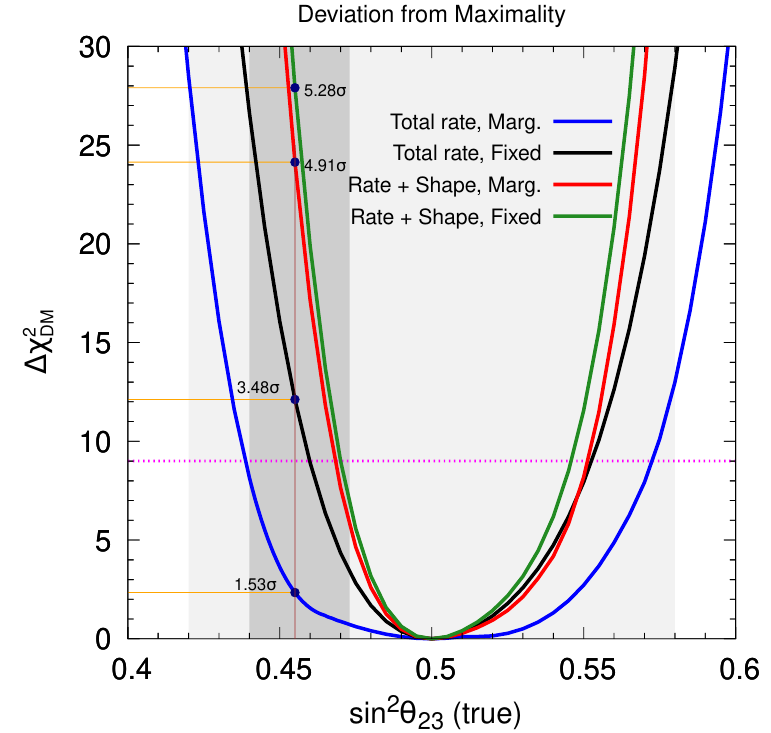
Figure 8 . Potential of DUNE to establish deviation from maximality as a function of true sin 2 θ 23 assuming true NMO and δ (true) = 223 ◦ with the combined 3.5 years ν + 3.5 years ¯ ν run. CP Blue (Black) curve shows the performance based on total event rates when ∆ m 2 and δ are CP 31 marginalized (fixed) in the fit. Red (green) curve depicts the sensitivity based on rate + shape analysis when ∆ m 2 and δ are marginalized (fixed) in the fit. See text for details. The dark CP 31 (light)-shaded grey area shows the currently allowed 1 σ (2 σ ) region in sin 2 θ as obtained in the 23 global fit study [11] with the best-fit value of sin 2 θ = 0 . 455 as shown by vertical brown line. The 23 horizontal orange lines show the sensitivity (experessed in σ = p ∆ χ 2 ) due to individual runs DM for the current best-fit value of sin 2 θ . The capability of DUNE to establish non-maximal θ at 23 23 3 σ ( ∆ χ 2 = 9 ) confidence level is shown by horizontal pink dotted line. For simplicity, we do not DM consider systematic uncertainties in this